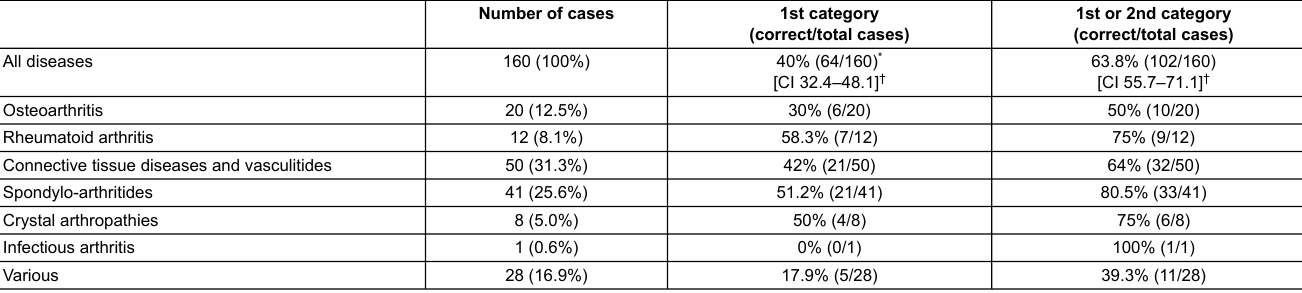
Table 2: Diagnostic precision of RT at time point